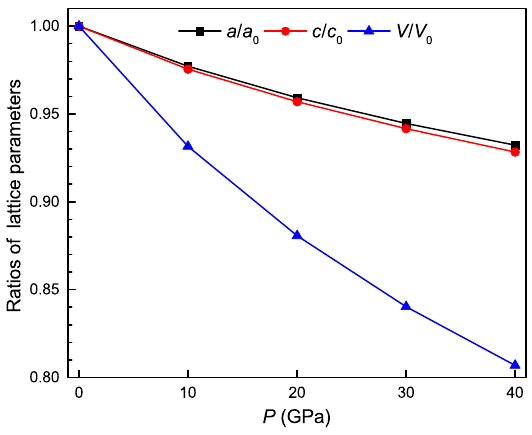
Figure 2. The ratios of lattice parameters as a function of pressure for the Ti 4 Nb 3 Al 9